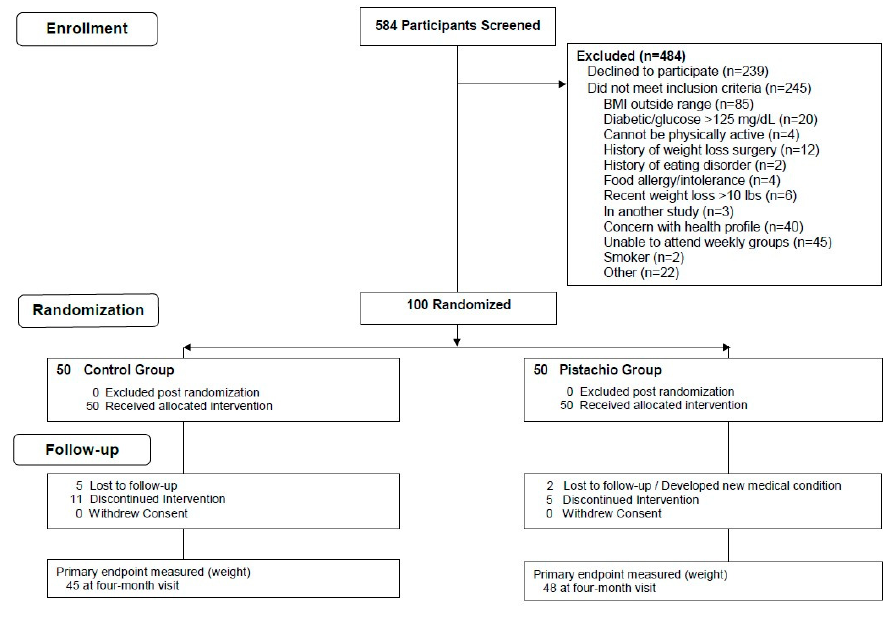
Figure 1. Flow chart for study participants.